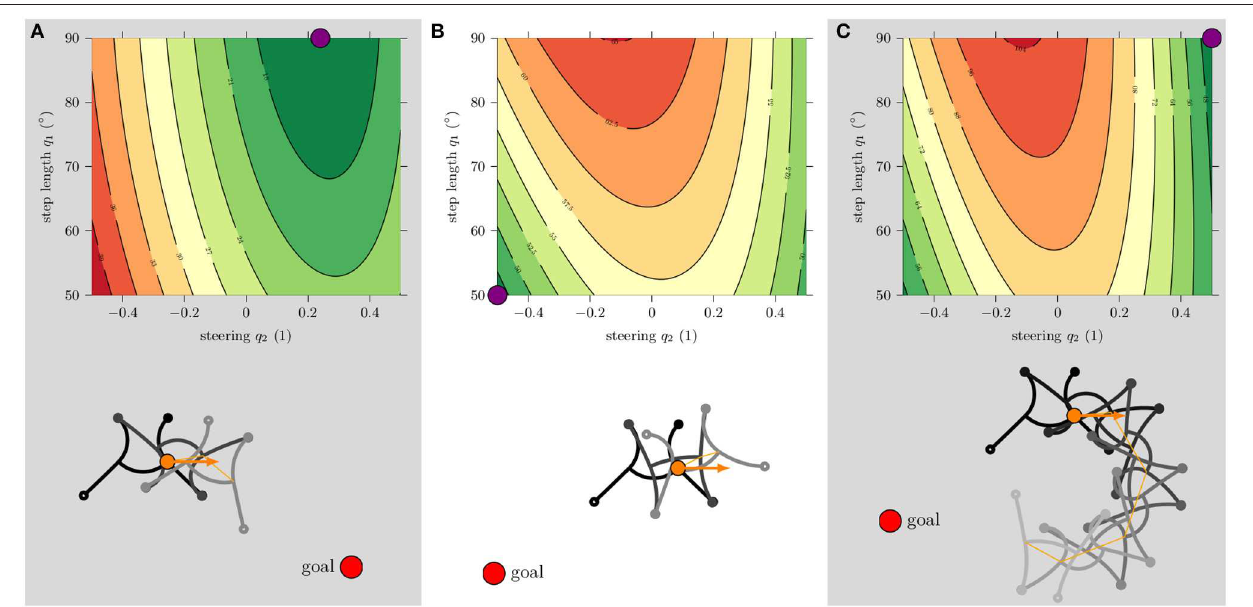
FIGURE 10 | Evaluation of the distance function d n for different target positions ¯ x and planning horizons n . The lowest values are represented by green and the highest values by red color. The lower image always shows the resulting simulated gait for n cycles, corresponding to the minimum distance (marked by a purple circle). Simulations were initialized with: O x = (0,0), O ε = 0 ◦ , α 0 = [90 0 − 90 90 0], f 0 = [1 0 0 1]. (A) Planning horizon n = 1 for target at ¯ x = (35, − 20), (B) n = 1 for target at ¯ x = ( − 35, − 20), and (C) n = 4 for target at ¯ x = ( − 35, − 20).